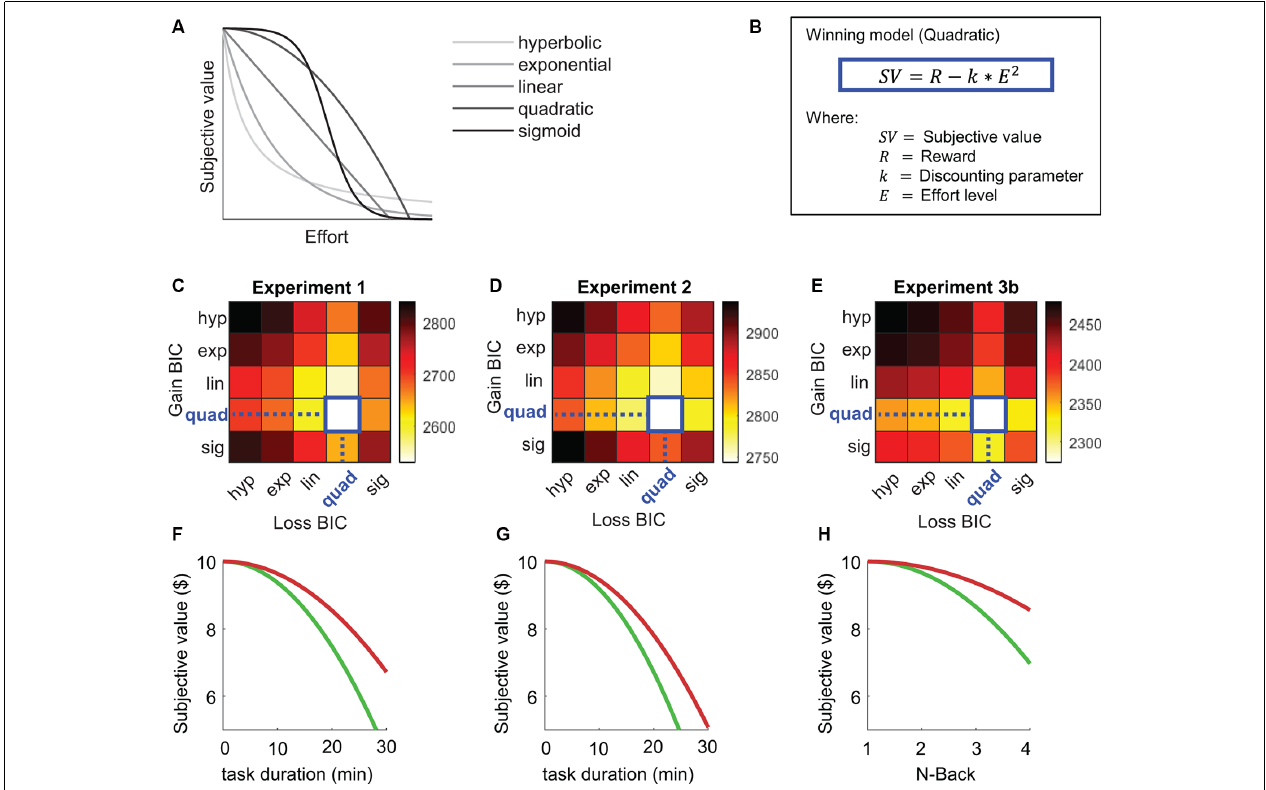
FIGURE 4 | Computational modeling results with (A) illustration of different discounting models, (B) winning model (Quadratic), (C–E) model comparison using Bayesian Information Criterion (BIC) in Experiments 1, 2 and 3b, and (F–H) average discounting curves for Gain (green) and Loss (red) framing conditions in Experiments 1, 2 and